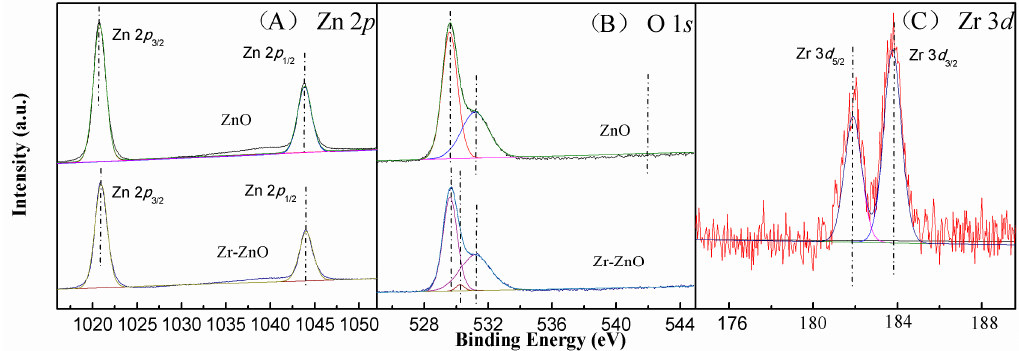
Figure 5. XPS profile of Zn 2p ( A ), O 1s ( B ), and Zr 3d ( C ) in the ZnO and Zr–ZnO catalysts.